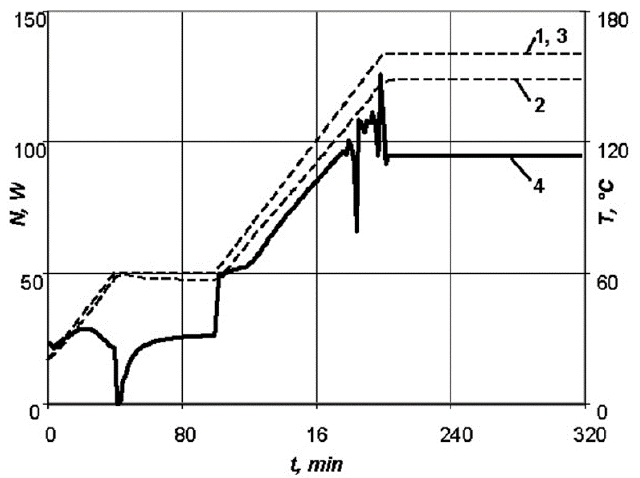
Figure 12. This is a figure. Schemes follow the same formatting. Dependences of parameters of the standard conditions of moulding for a patch of 4 mm thick: 1—temperature versus time on the lower surface of the product; 2—temperature versus time on the upper surface of the product; 3—temperature versus time for the standard conditions; 4—power versus time.